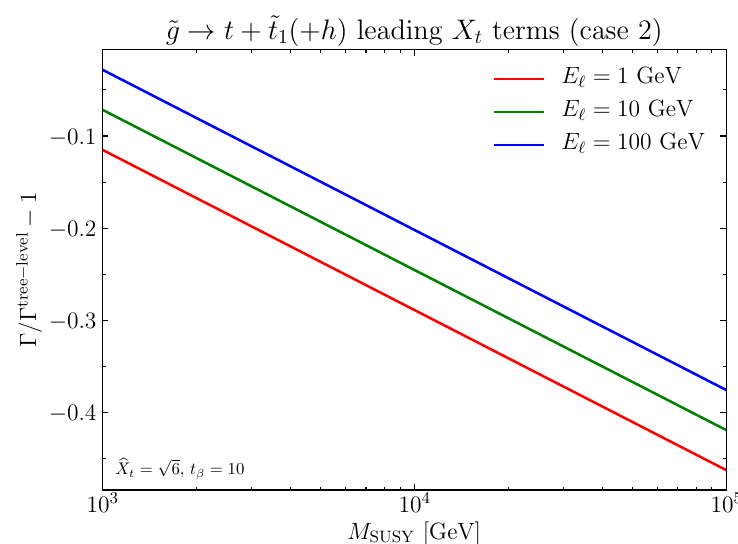
Figure 13. The gluino decay width ˜ g → t + ˜ t 1 (+ h ) at one-loop order including the corrections in leading powers of X t is shown relative to the tree-level decay width as a function of M SUSY . The result is shown for different detector resolutions: E ‘ = 1 GeV (red), E ‘ = 10 GeV (green), and E ‘ = 100 GeV